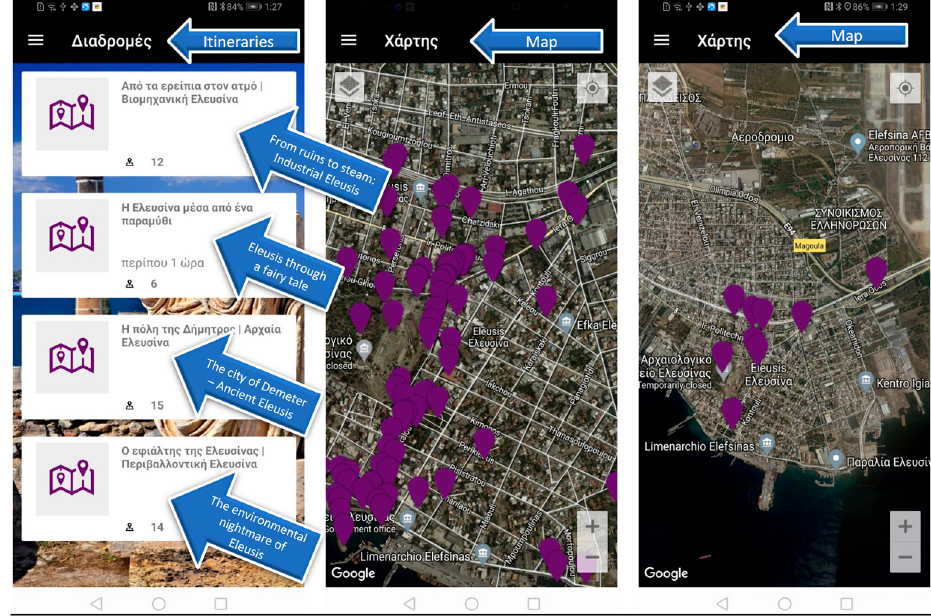
Figure 1. The three main ways to access the digital ecomuseum content through the app. ( Left ) The- matic routes, proposing specific thematic itineraries to the user. ( Middle ) The map view with all available POIs on the map. ( Right ) The personalized map view. Only the 10 most recommended POIs are visible.